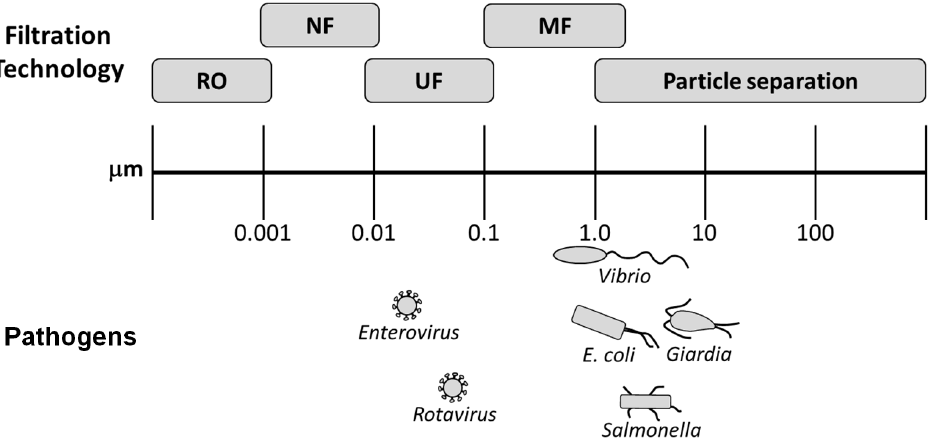
Figure 1. Membrane filtration spectrum for rejection of pathogenic microorganisms (adapted from [11]).